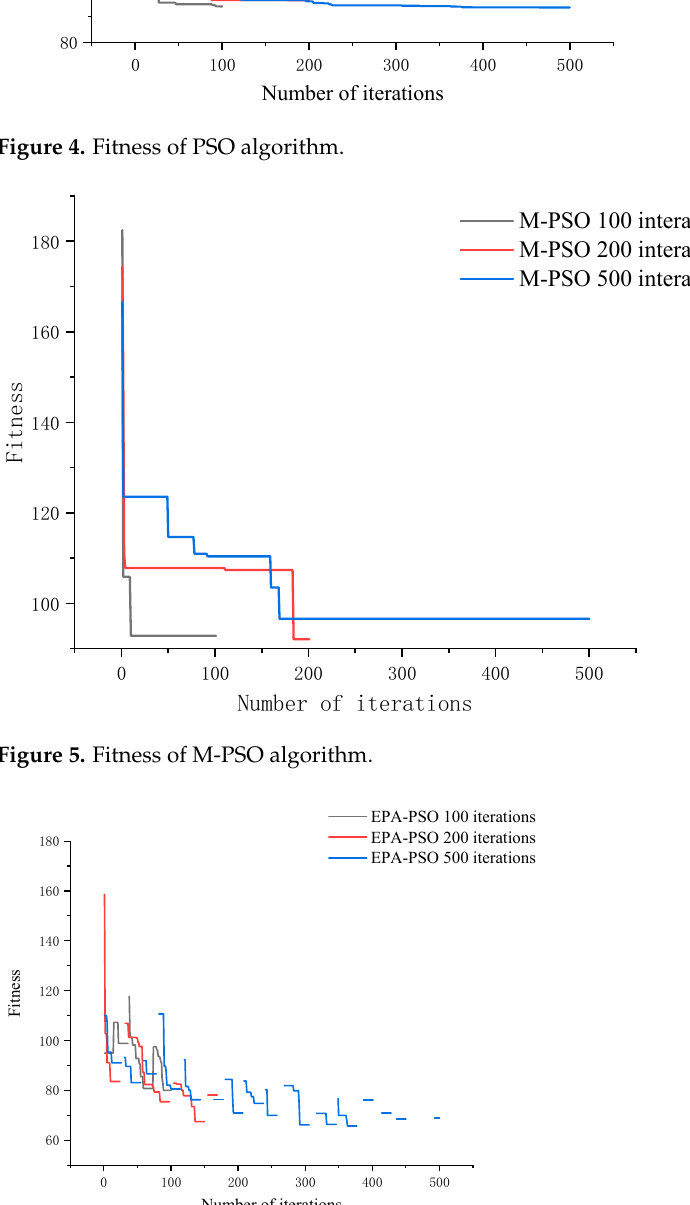
Figure 7. Inertia weight. 0